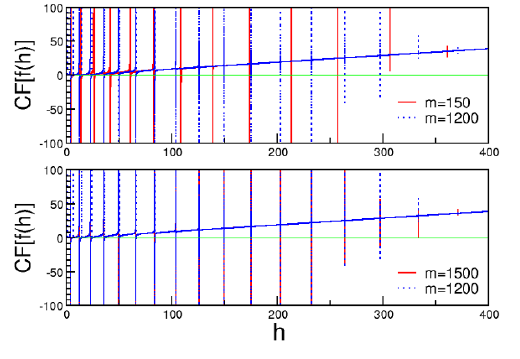
Figure 6. Plot of the continued fraction CF [ f ( h )] for n = 3 spikes. In the upper (cid:12)g- ure the red curve is for m = 150 and the blue is for m = 1200. In the lower (cid:12)gure, the red curve is for m = 1500 and the blue one is for m =